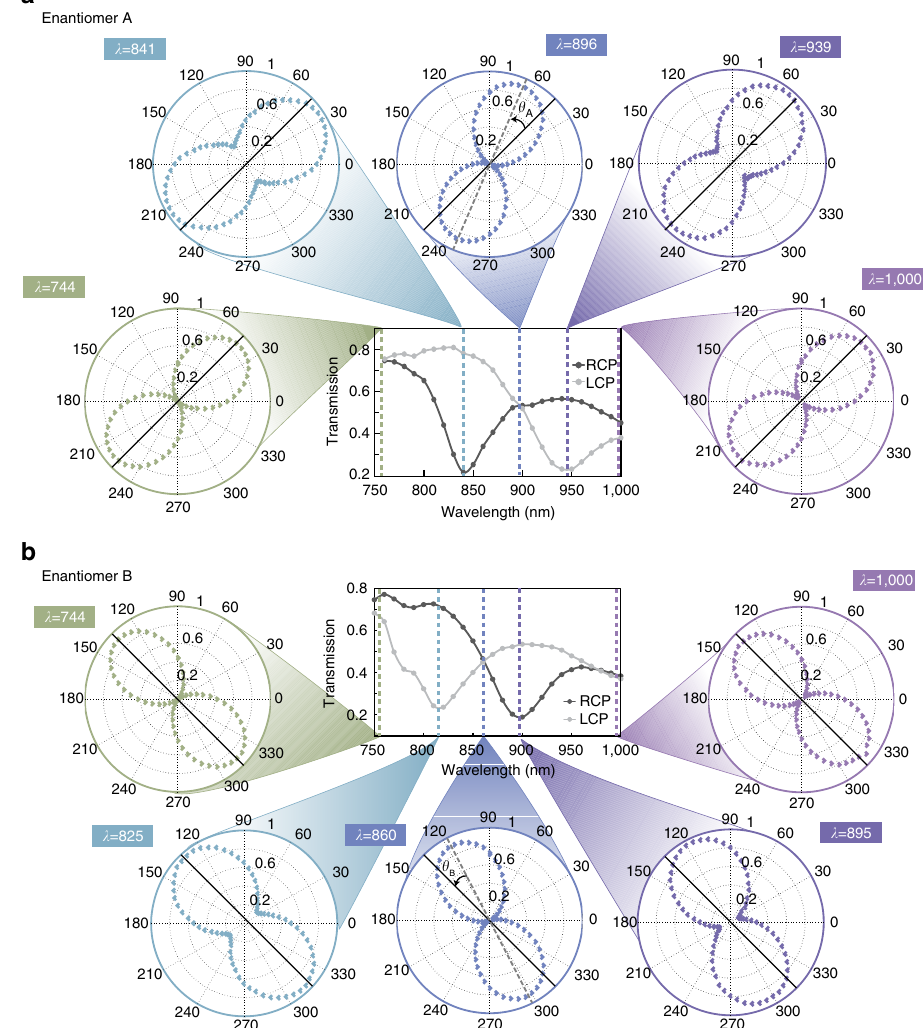
Figure 2 | Experimental chiroptical responses for the two enantiomers. ( a ) Transmission spectra for left and right circular polarizations incident on enantiomer A. The spectra present a maximum circular dichroic response of 0.58, where CD is defined as T RCP (cid:3) T LCP . Optical rotation measurements were performed with a linear polarization input at 45 (cid:2) , denoted by the black line in the polarization graphics. The diagrams measured at 744nm and 1 m m show that the linear polarization and orientation is maintained as it passes through the structure. At the spectral location of the resonance dips, 841 and 939nm, the output polarization becomes elliptical and rotated. At the spectral cross-point in the central graphic, where T RCP ¼ T LCP at the wavelength of 896nm, the transmitted light remains linearly polarized, but rotated by 25 (cid:2) clockwise. ( b ) Mirror responses are achieved for the transmission and optical rotation data of enantiomer B, when a linear polarization is input at an angle of 135 (cid:2) . Similar to enantiomer A, the linear polarization is maintained at the cross-point wavelength where T RCP ¼ T LCP , but the optical rotation is counter clockwise in this